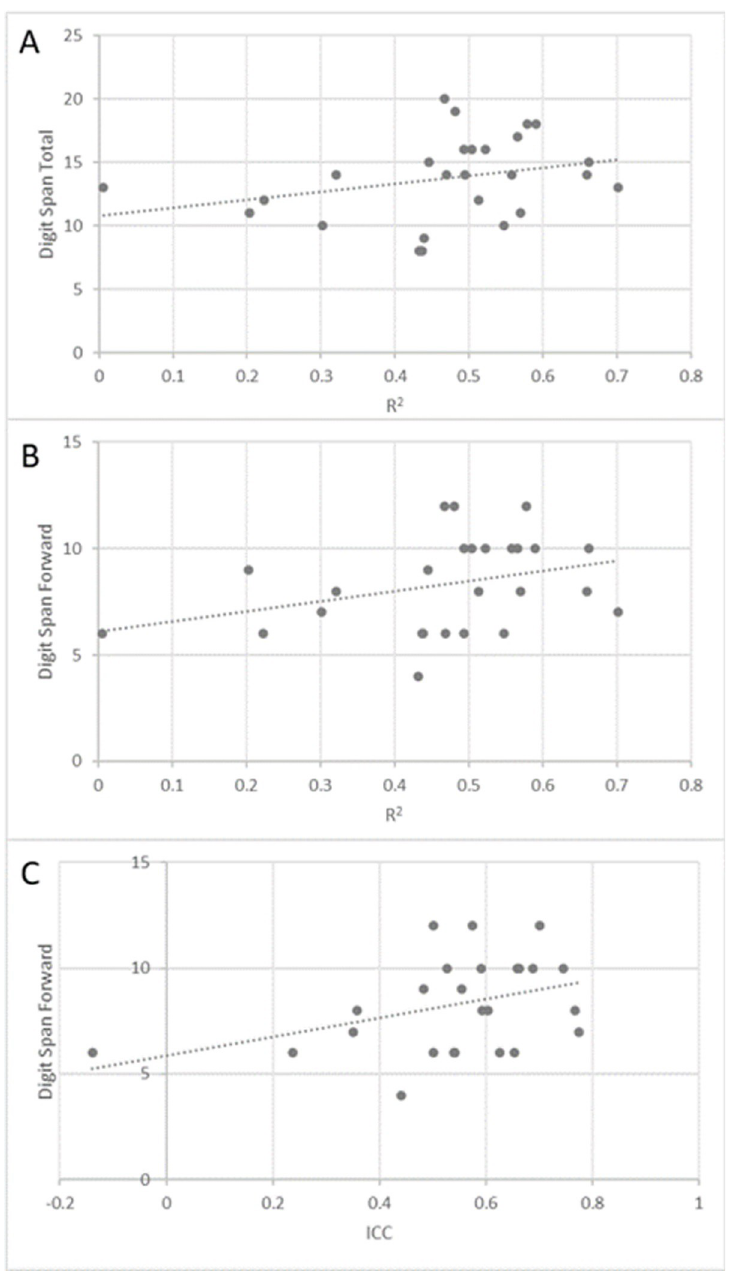
Fig 3. Correlations between forward-order and total digit span scores and FAST R 2 and ICC, Fibromyalgia group. Correlations between the Digit span total and forward scores and the FAST outcomes in the fibromyalgia group. Fig 3A shows the correlation between the Digit span total and the FAST R 2 . Fig 3B and 3C present the correlations between Digit span forward and the FAST R 2 and FAST ICC,